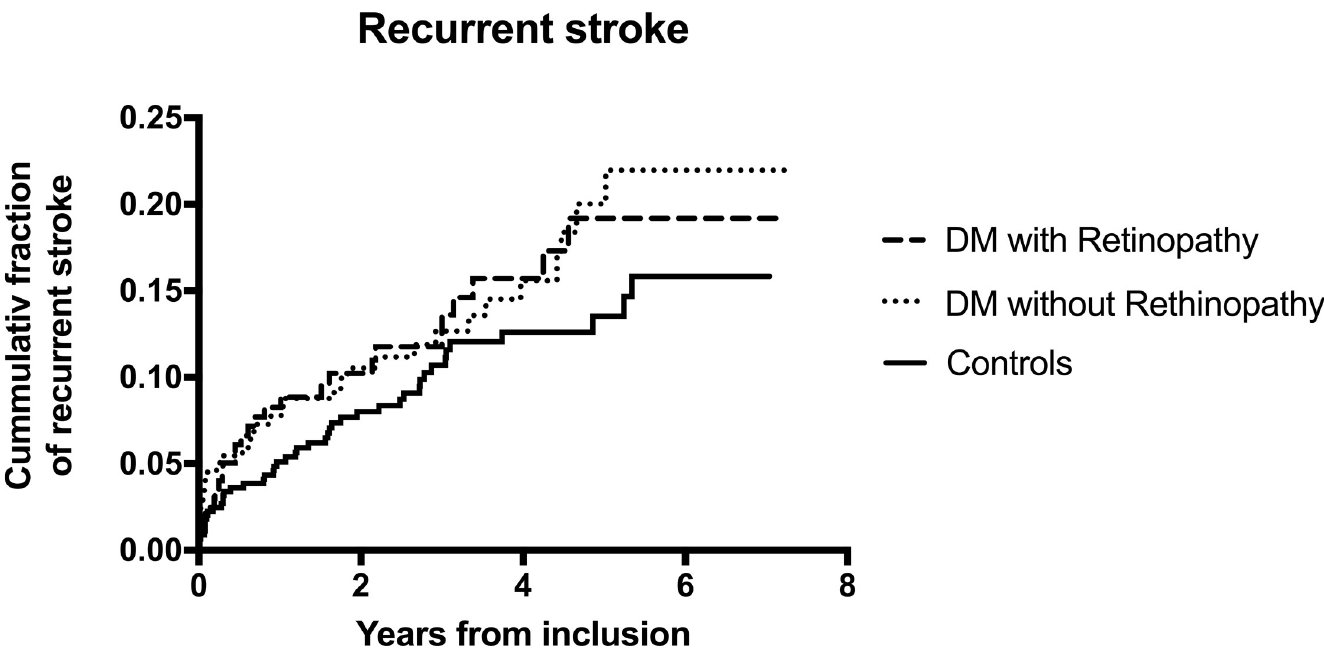
Fig 1. Kaplan-Meier curve of the cumulative proportion with recurrent stroke. P-value for the difference between patients with and without diabetes was 0.07. P- value for the difference between diabetes patients with and without retinopathy was 0.96.